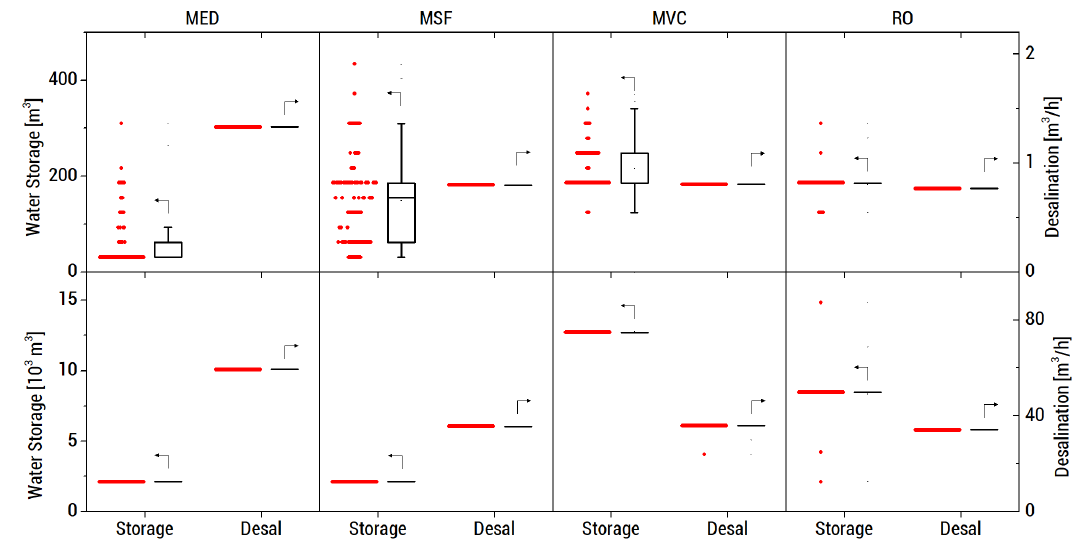
Figure 9. Distribution of optimum sizes of water storage ( left axis) and desalination unit ( right axis) on Camasusu Island ( top ) and Lubang Island ( bottom ). There is high uncertainty in the optimum water storage sizes in Camasusu, except for RO.